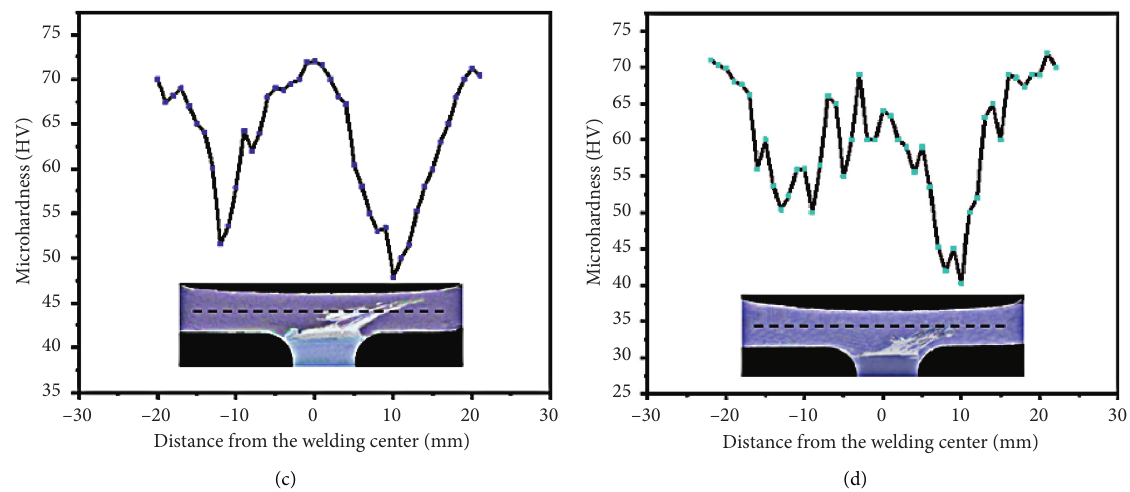
Figure 16: Sketch maps of microhardness tests on the skins with different traverse speeds: (a) 15mm/min; (b) 30mm/min; (c) 50 mm/min; (d) 65mm/min.